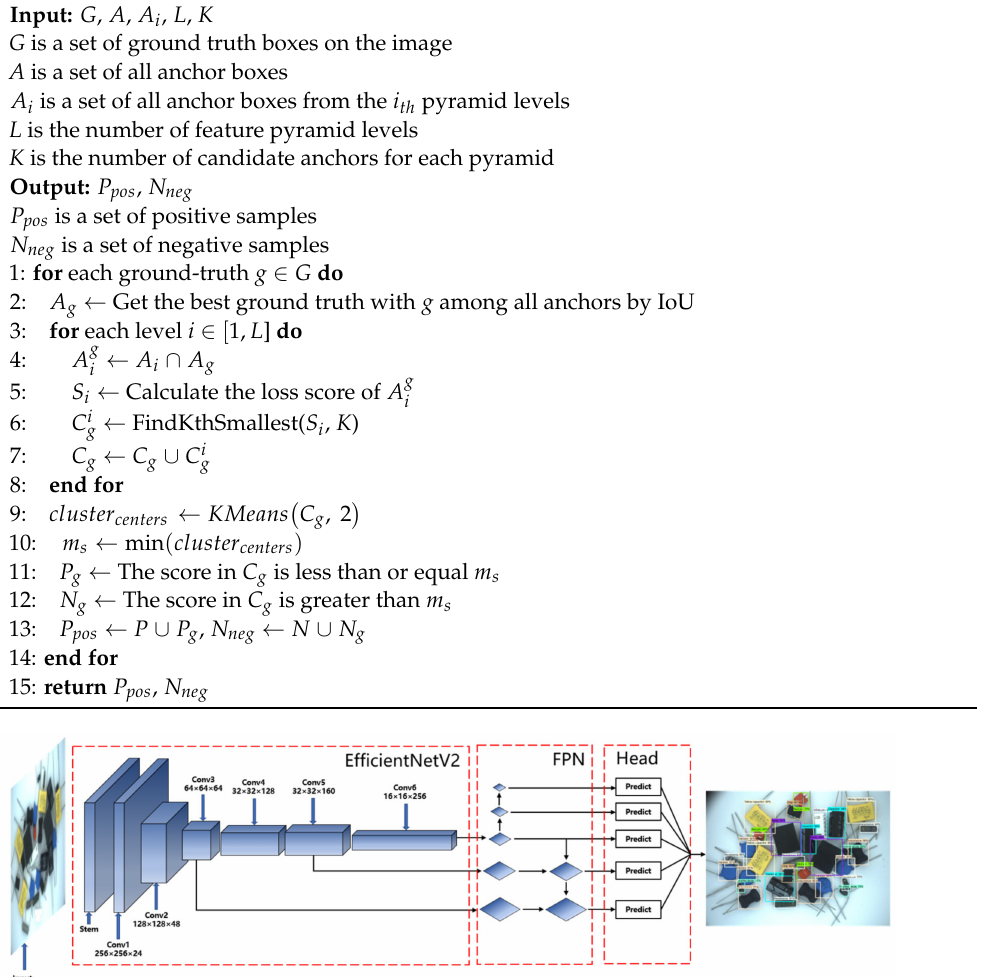
Algorithm 1. K-Means-based anchor assignment algorithm.